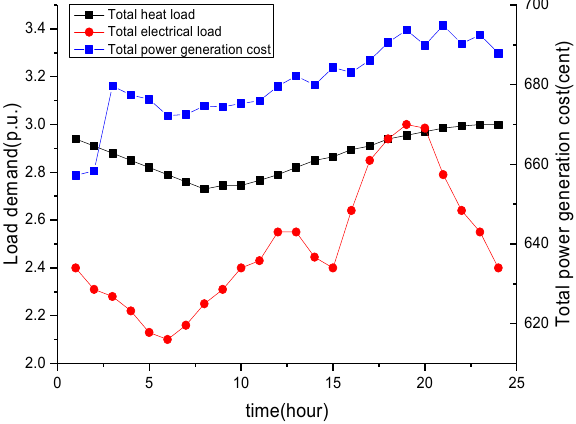
Figure 7. 24-h change in total cost of power generation, total electrical load, and total heat load.